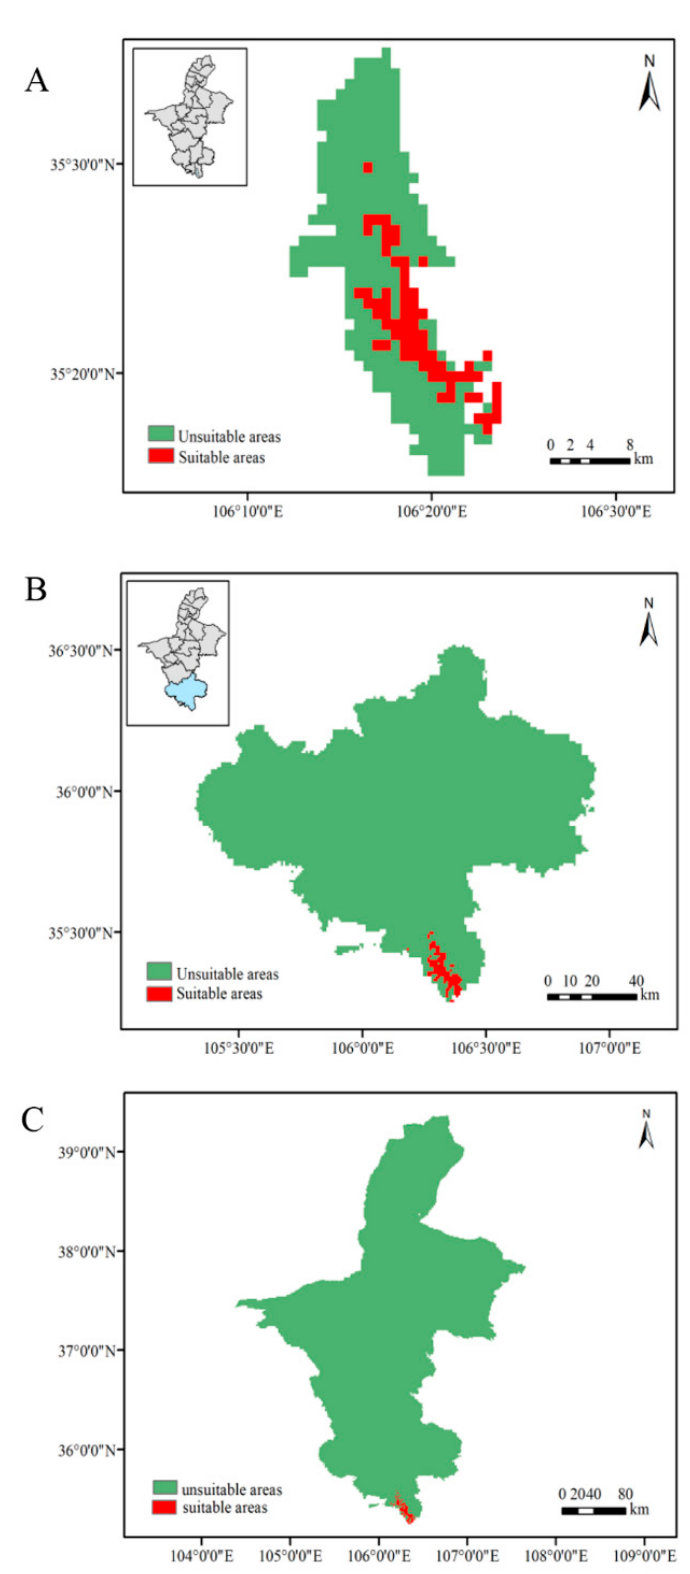
Figure 4. Prediction of the suitable habitat area for leopards at different geographical scales. ( A ). Distribution of suitable habitats for leopards in Liupanshan National Nature Reserve. ( B ). Distribution of suitable habitats for leopards in Guyuan. ( C ). Distribution of suitable habitats for leopards in Ningxia.